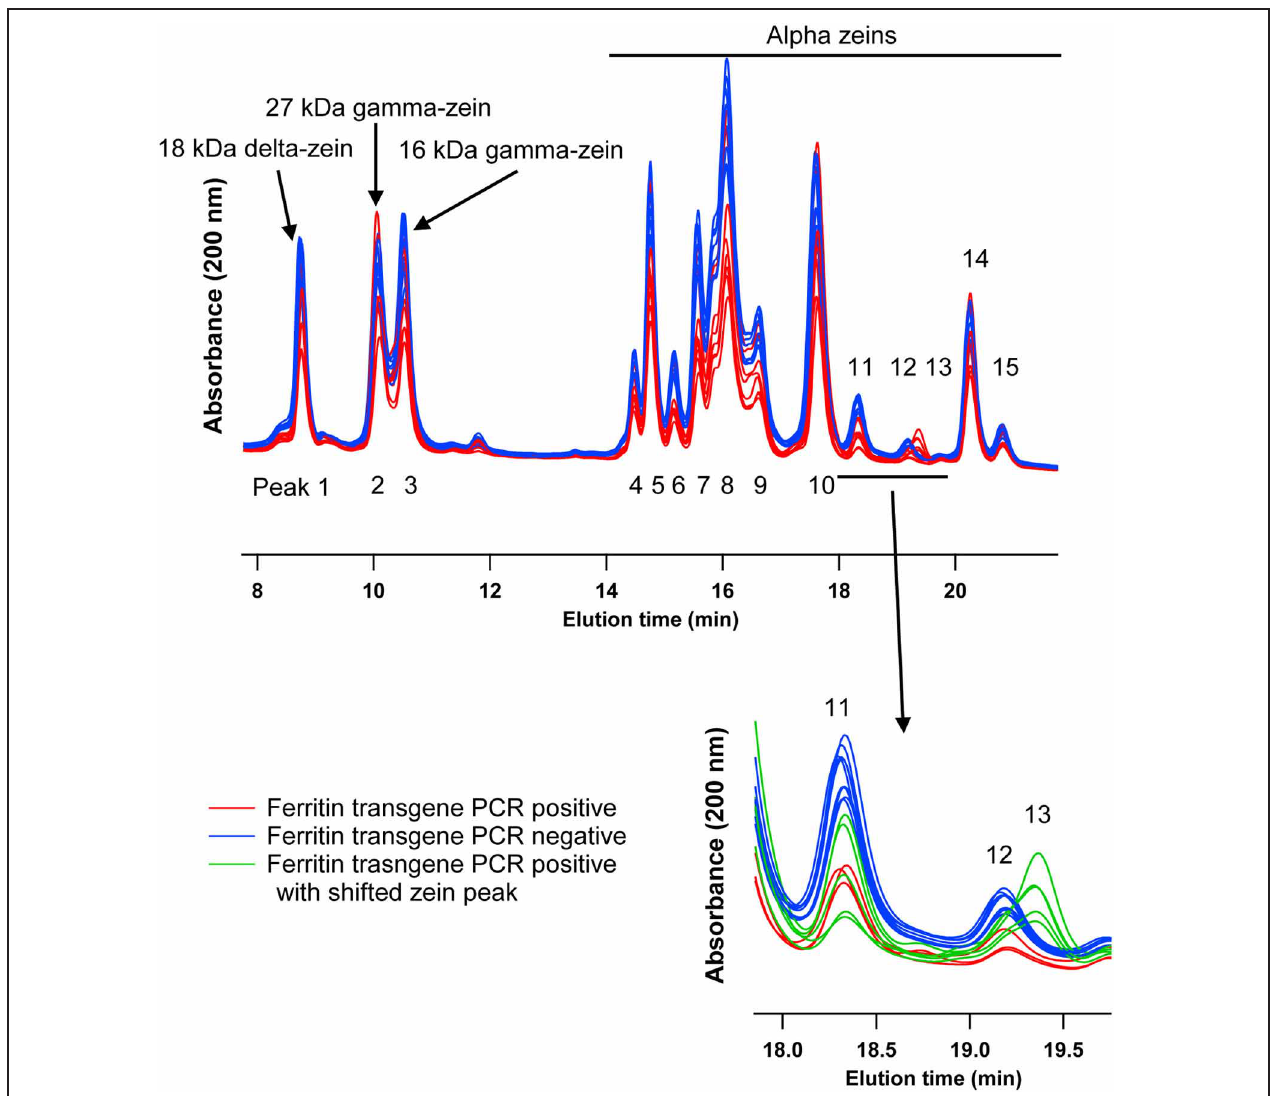
FIGURE 5 | HPLC chromatogramsof maize zeins for maize seed endospermstransformed withthe soybean ferritintransgene. Maize seed endosperms were screened with PCR to identify soybean ferritin positive (Red or bottom) and negative (blue or top) seed samples. Samples were separated